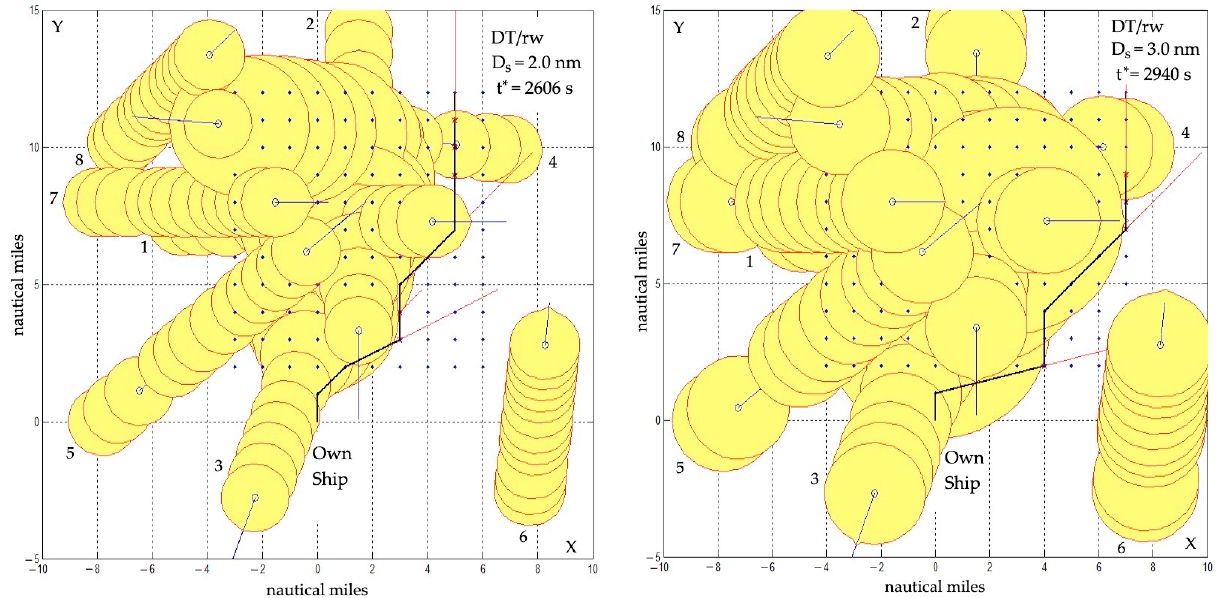
Figure 13. Safe dynamic trajectory of one’s own ship determined by the DT algorithm with neural domains of passing ships in the forms of circle, hexagons, ellipses, and parabolas with restricted visibility at sea at different values of the adopted safe passing distance D s ; t* is the optimal time to avoid a collision situation. The shape of the domain has a significant impact on the course of the ship’s safe trajectory and its final deviation from the set trajectory. The use of a domain in the form of a parabola increases the safety of anti-collision maneuvering at the cost of increasing the final trajectory deviation from the initial value.